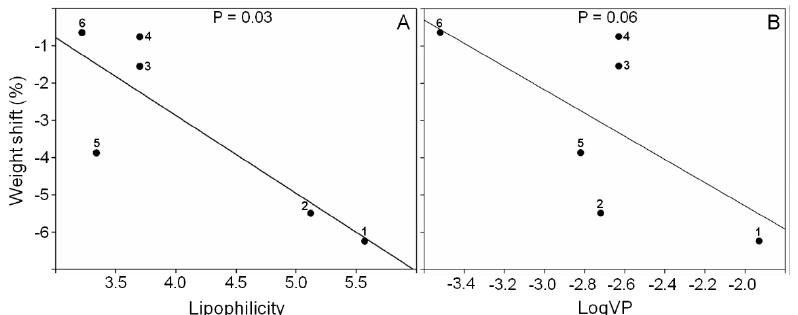
Figure 3. ( A ) Correlations between weight shift (%) and lipophilicity and ( B ) between weight shift (%) and LogVP. For logVP, values near to zero indicated higher vapor pressure. The sesquiterpenes were (−)- trans -calamenene ( 1 ), cadalene ( 2 ), (−)-cubenol ( 3 ), (−)- epi -cubenol ( 4 ), ( − )-torreyol ( 5 ) and (−)- 15-copaenol ( 6